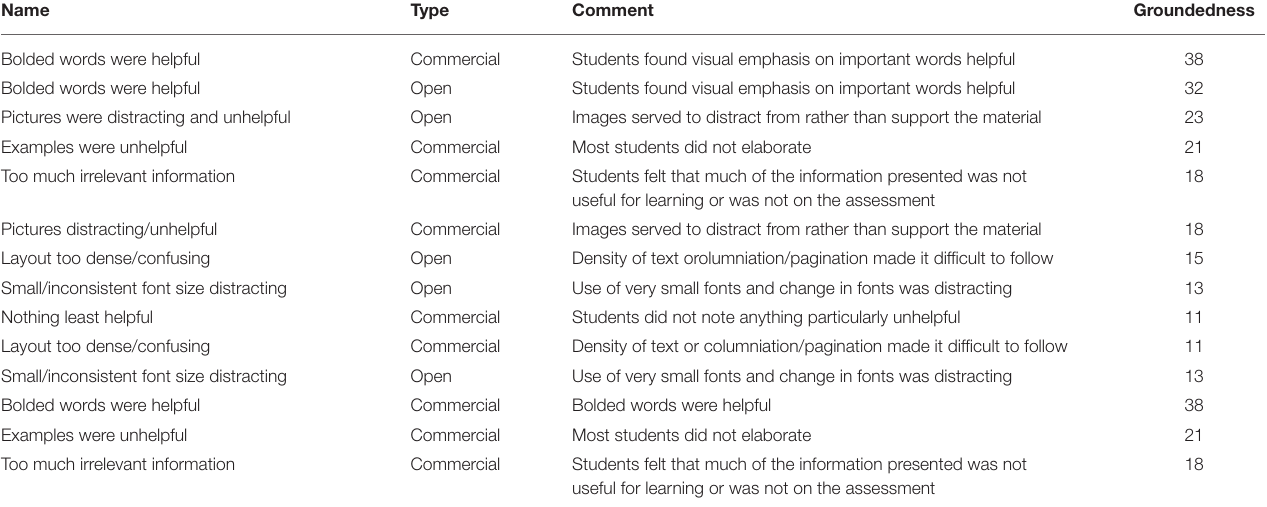
TABLE 2 | Ten most grounded codes.